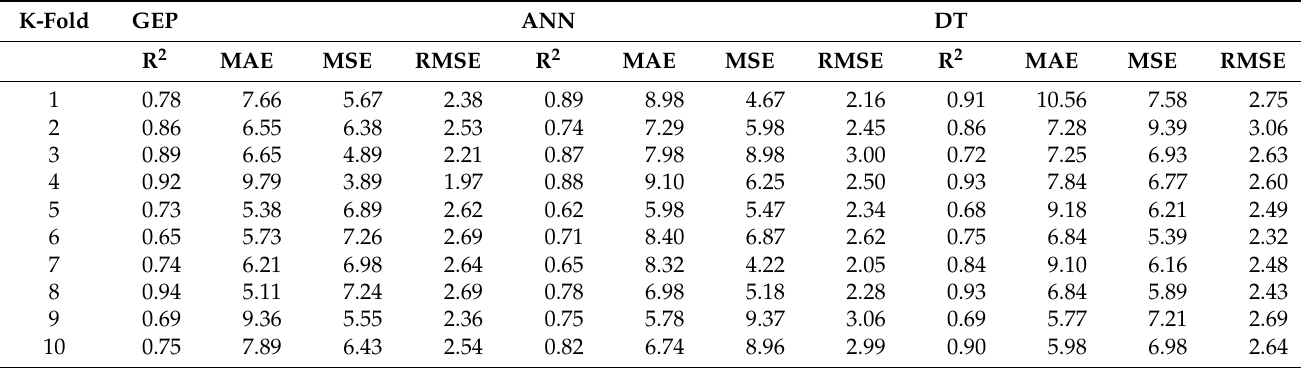
Table 4. Results of k-fold cross validation.